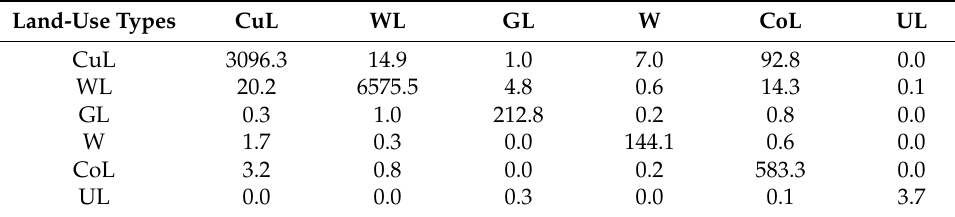
Table 3. Land-use transfer matrix for 2005–2010 ( km (cid:2870) ). Land-Use Types